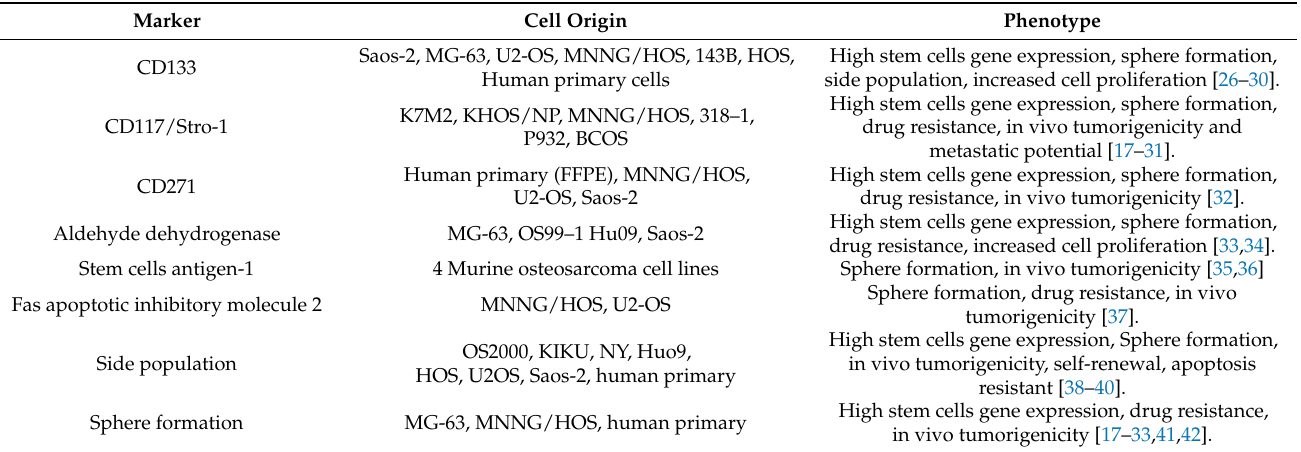
Table 1. Putative OSC markers and